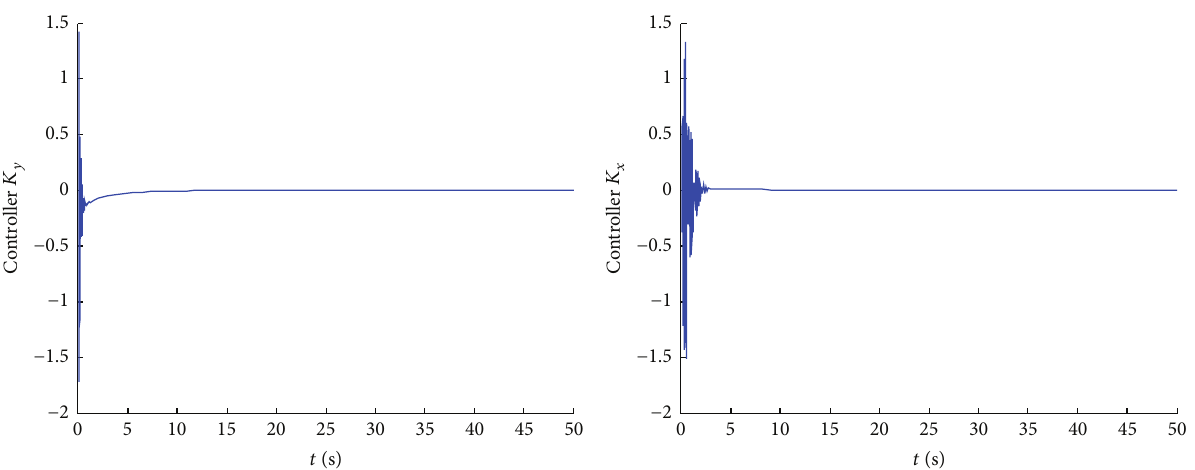
Figure 5: Amplitudes of controller 𝐾 for flap/lag motions under 𝑈 = 65